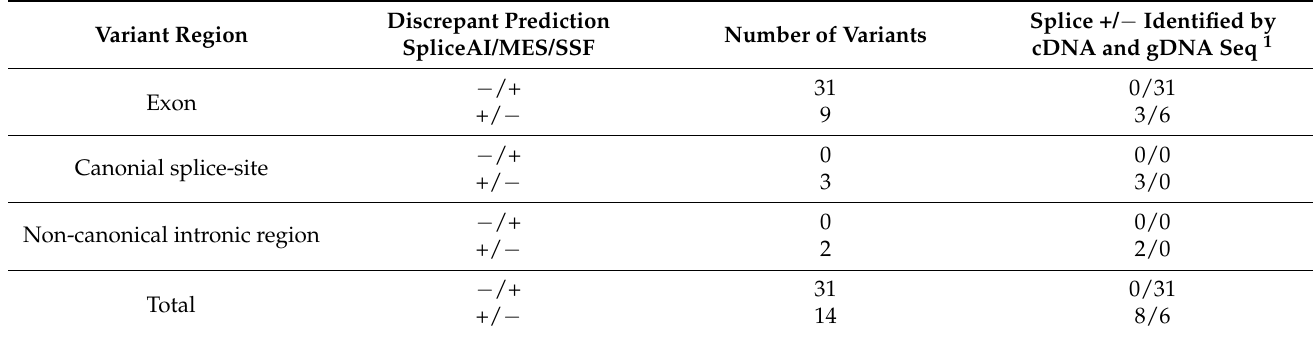
Table 4. Discrepant prediction between SpliceAI and